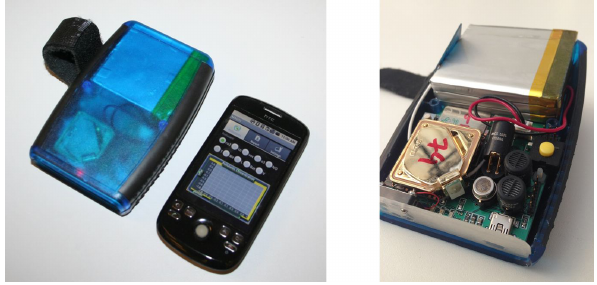
Figure 1. The M-Pod and the accompanying MAQS3 phone appli-